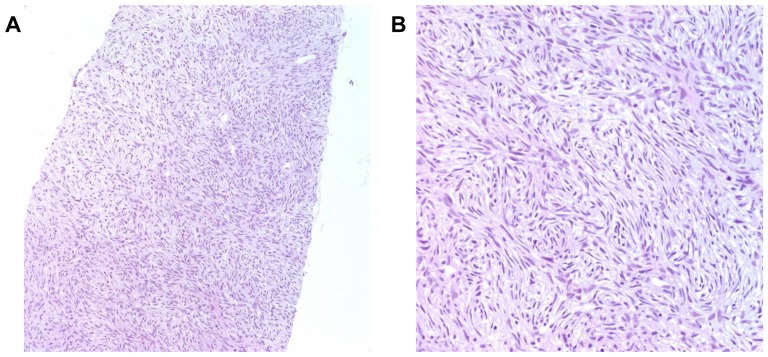
Pathological examination of tumor.A, Hematoxylin-eosin staining is showing spindle-shaped cells organized in a storiform pattern characteristic of DFSP (×100 magnification). B, (×200 magnification).